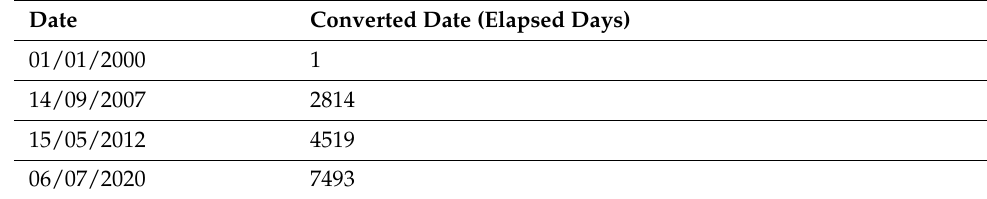
Table 10. Examples of conversion from dates to days with respect to